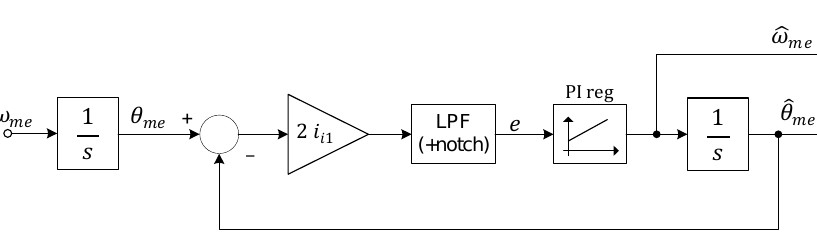
𝑖 𝑖 , 𝑑𝑒𝑚𝑜𝑑 𝒙 𝑖 𝑖 , 𝑑𝑒𝑚𝑜𝑑 𝒚 Figure 1. Typical algorithm for position estimation based on rotating-voltage High Frequency Injection (HFI) [7]. 3. Estimation PLL Dynamics and Tuning With respect to other methods (e.g., fundamental-based), the dynamics of HFI-based speed and position estimation has been investigated less extensively. However, effective analytical approaches for PLL gains design have been proposed, e.g., [19,20], where the specific aspects of these methods, such as the effect of filtering and demodulation, are taken into account. In fact, as mentioned in the introduction, manual tuning might be restricted or even unacceptable in certain cases, due to many reasons. On the other hand, analytical tuning strongly relies on the knowledge of differential inductances, which are often unavailable for off-the-shelf machines and usually vary with the operating point, due to magnetic saturation. The proposed analysis of dynamics is similar in principle to the one in [20], where linearization is applied and the frequency response of filters is considered in order to obtain a straightforward representation of the loop dynamics, which represents the basis of the proposed method. Considering small values of the error, the non-linear sine function can be approximated to its argument, i.e., from the dynamics point of view the small-signal equivalent of the error signal will be 𝑒 ≈ 𝐿𝑃𝐹{2 𝑖 𝑖1 · (𝜃 𝑚𝑒 − 𝜃̂ 𝑚𝑒 )} (16) The error signal is approximately proportional to the difference between actual and estimated